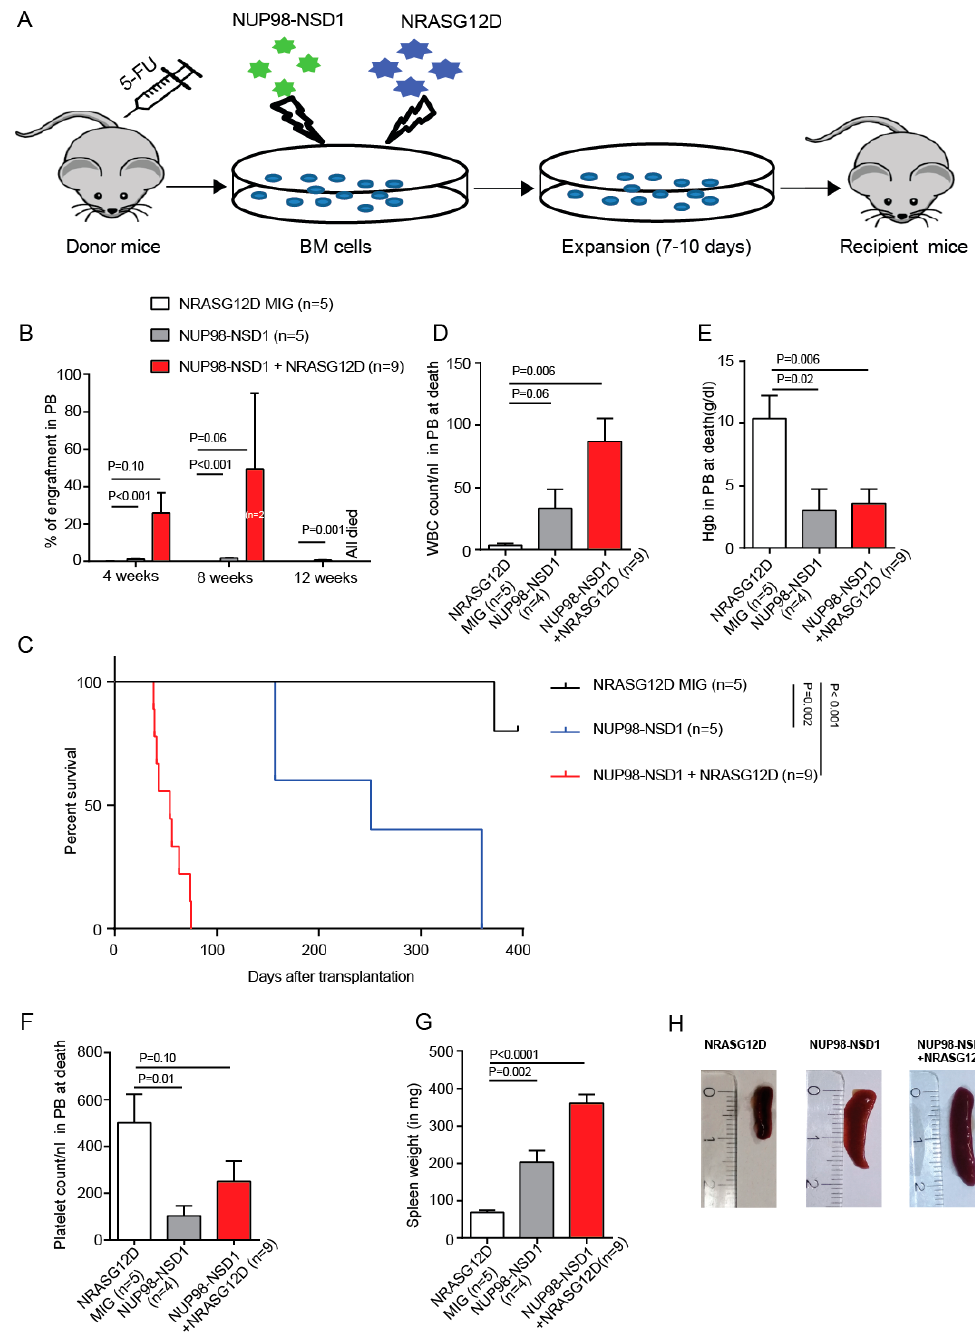
Figure 2. NUP98-NSD1 induces a long-latency AML and cooperates with NRASG12D to induce an aggressive acute myeloid leukemia in vivo. ( A ) Development of syngeneic mouse models using constitutively expressed NRASG12D, NUP98-NSD1, or both. ( B ) Engraftment of transduced cells in peripheral blood of the indicated groups 4, 8, and 12 weeks after transplantation (mean ± SEM). ( C ) Survival of mice that received transplants of cells transduced with the indicated constructs. ( D ) White blood cell count in peripheral blood at time of sacrifice from mice, which received transplants of the indicated cells (mean ± SEM). ( E ) Hemoglobin levels in peripheral blood at time of sacrifice of mice, which received transplants of the indicated cells (mean ± SEM). ( F ) Platelet count in peripheral blood at time of sacrifice of mice, which received transplants of the indicated cells (mean ± SEM). ( G ) Average spleen weight in mice at time of sacrifice of mice, which received transplants of the indicated cells (mean ± SEM). ( H ) Representative image of a spleen at time of